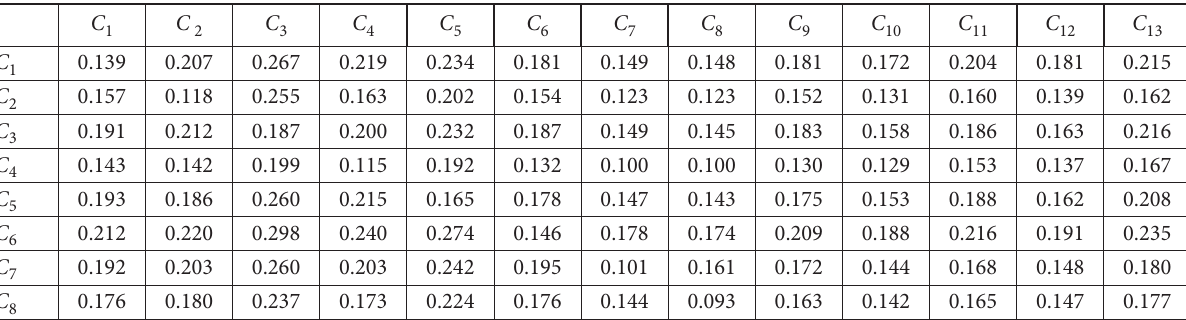
Table 6. Total influence relationship matrix for criteria M